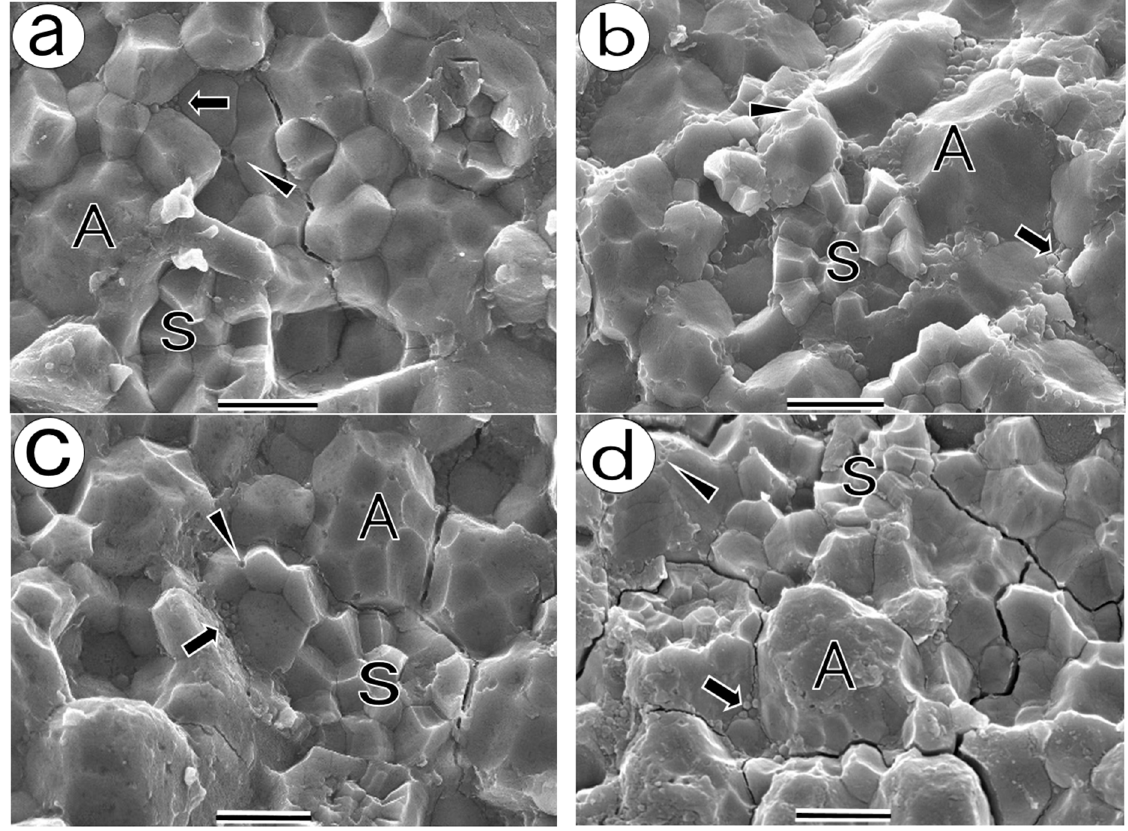
Figure 1. Accumulation structures of rice grain in selected varieties: ( a ) Attai-1, ( b ) Jalalabad-14, ( c ) Shishambagh-14, and ( d ) Zodrass. A: amyloplast; S: starch granules; arrow: protein bodies; arrowhead: traces of protein bodies. Bars: 10 µm.